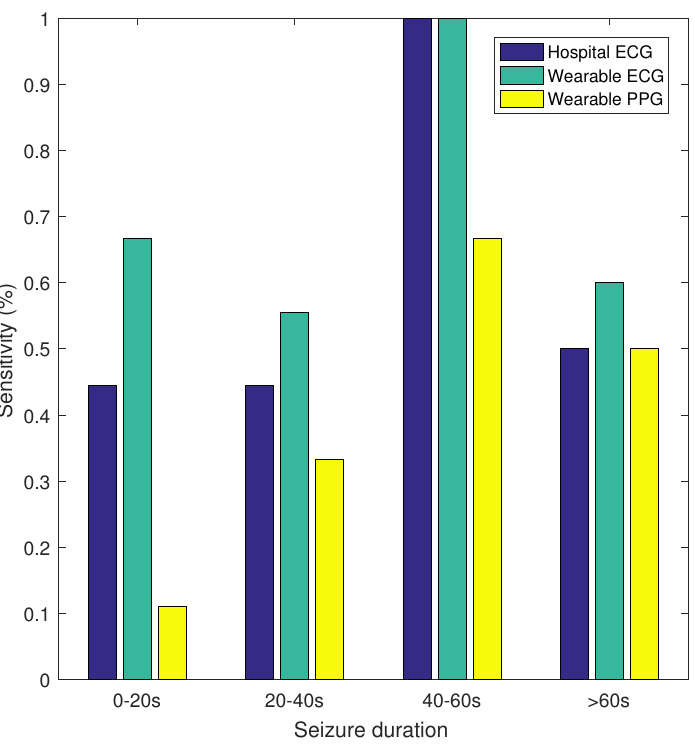
Figure 3. Sensitivity versus seizure duration.